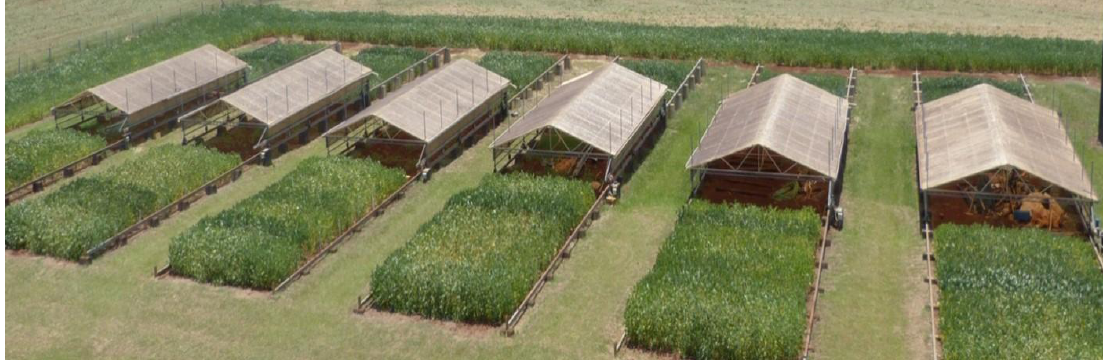
Figure 1. Rainout shelters used to induce water deficit in soybean in Londrina, Brazil.